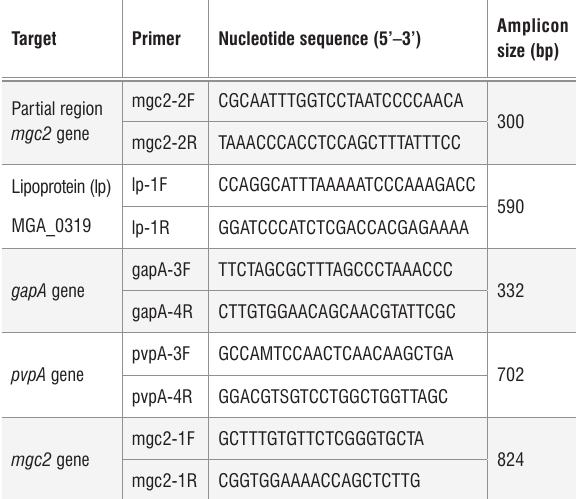
Nucleotide sequence of the primer pairs of the targeted genes together with the predicted amplicon sizes based on the Mycoplasma gallisepticum R